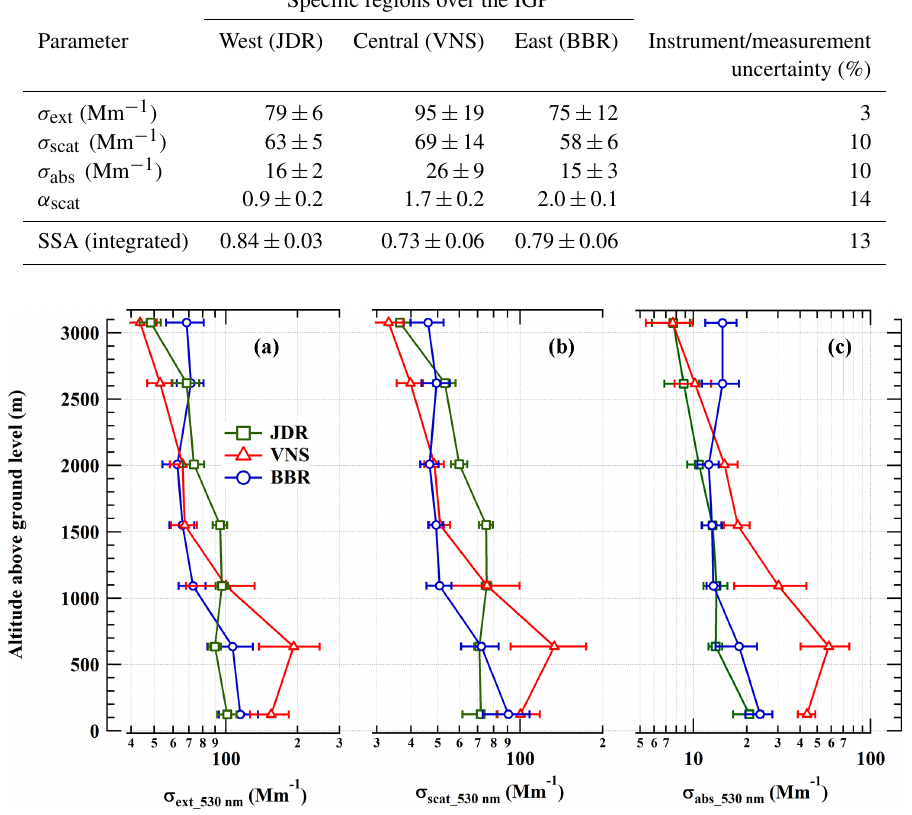
Figure 3. Mean altitudinal variation of (a) σ ext , (b) σ scat and (c) σ abs over JDR (square), VNS (triangle) and BBR (circle) in logarithmic scale. Error bars represent the corresponding standard errors (standard deviation of the